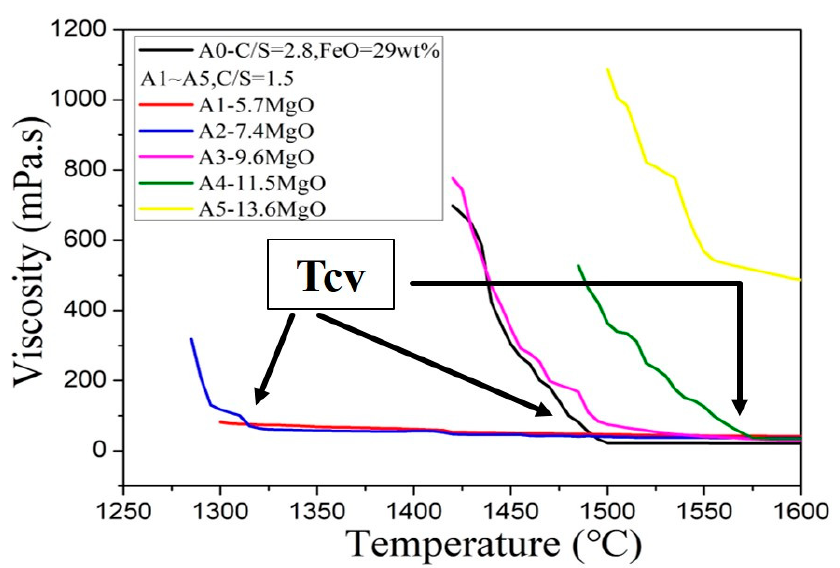
Figure 5. Viscosity curve of the CaO-SiO 2 -MgO-5Al 2 O 3 -30FeO slag system.